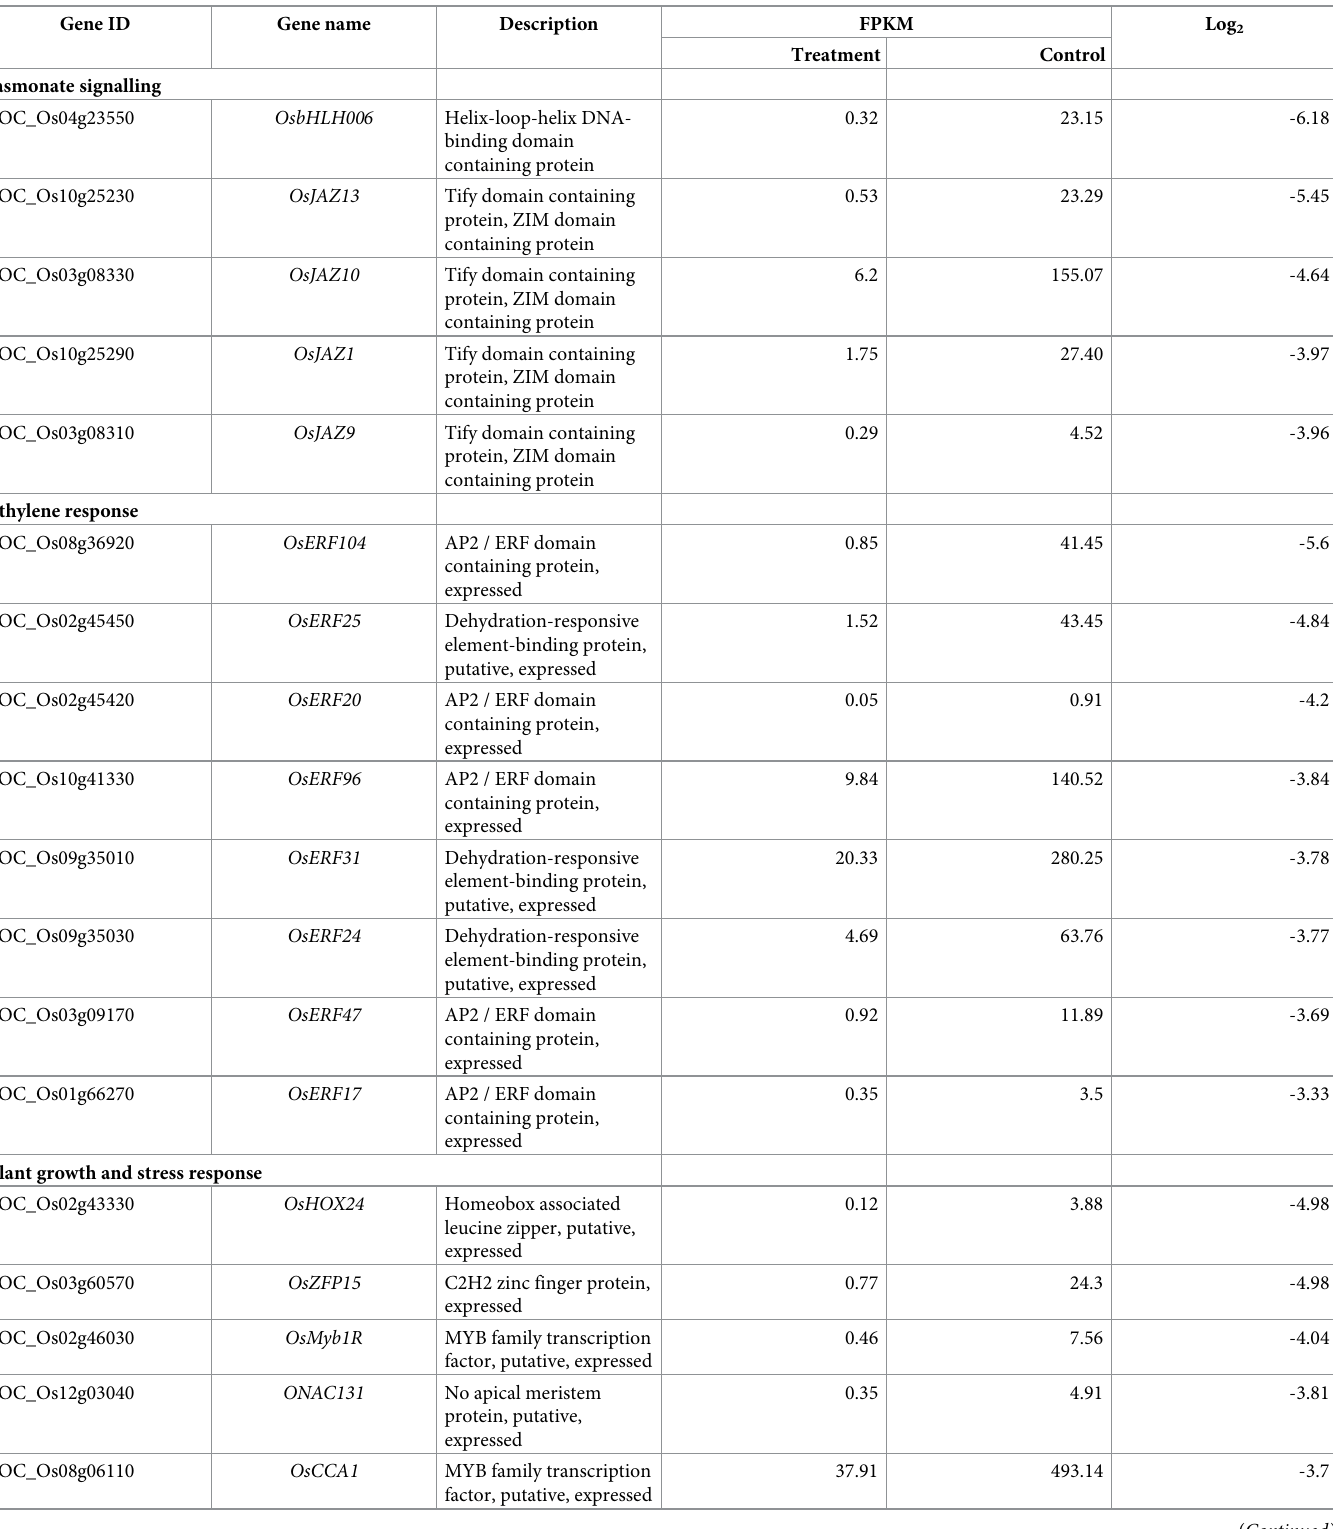
Table 3. The expression profile of downregulated transcription factor families in the 100 most differentially expressed genes in T8. Gene